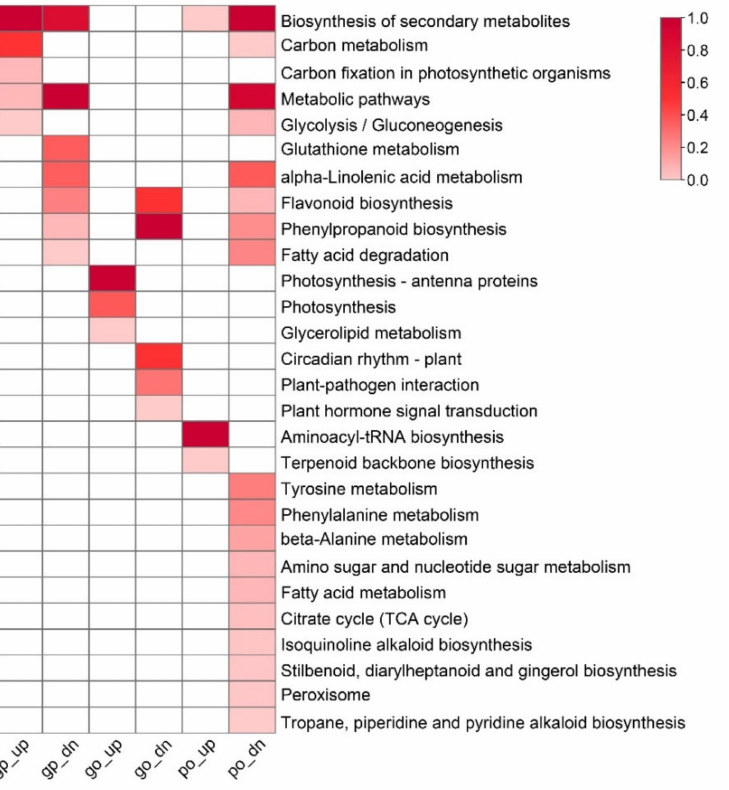
Figure 6. Functional category enrichment of DEGs/DEPs. DEGs/DEPs were classified into a total of 6 groups according to RNA-Seq and iTRAQ integrative analysis. The degree of the pathway enrichment was indicated according to the value of − log( q -value), as shown in the color bar. Each group was indicated by expression level (“go” for gene only, “po” for protein only, and “gp” for both gene and protein level, respectively) and regulatory direction (“up” for up-regulated and “dn” for down-regulated, respectively). The color brightness represents the degree of significant enrichment of pathways, as shown in the color